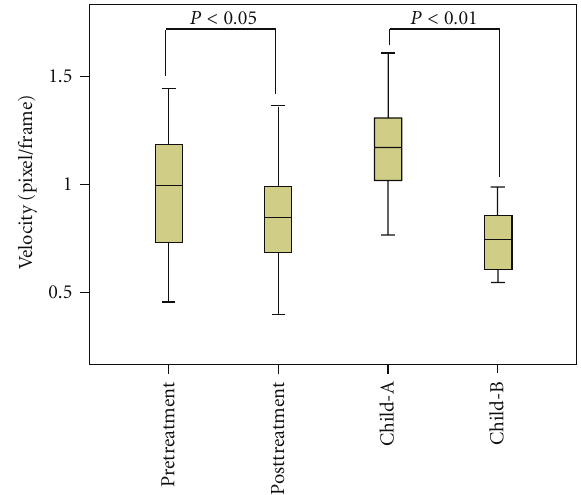
Figure 3: The statistic comparison of blood flow before and after TACE/Child-Pugh